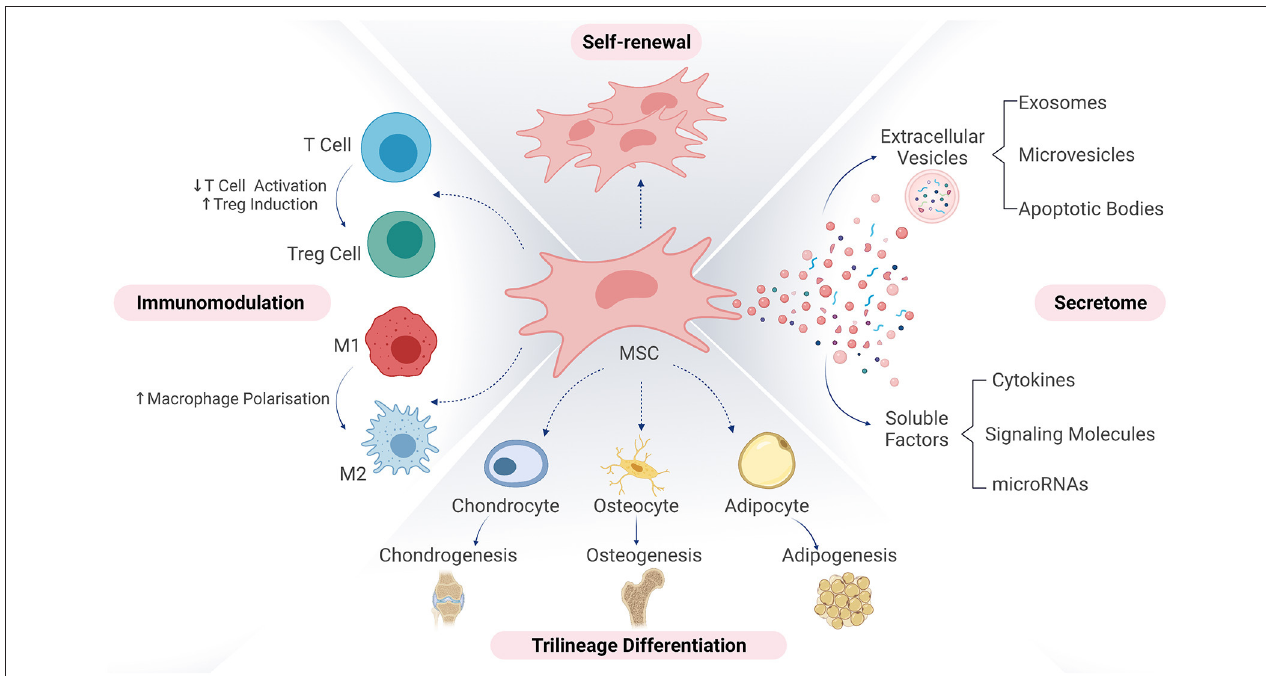
FIGURE 1 | Therapeutic mechanisms of action of mesenchymal stromal cells. MSCs are defined by their ability for self-renewal, proliferation and undergo tri-lineage differentiation into adipogenic, chondrogenic and osteogenic lineages. They contribute to tissue repair via multiple proposed mechanisms of actions. These include a direct contribution to tissue repair via engraftment and cell differentiation but also immunomodulation of host immune system by counteracting the pro-inflammatory cascades and establishing an anti-inflammatory micro-environment for tissue healing and secretion of extracellular vesicles and soluble factors responsible for intracellular communication with target cells. Treg, regulatory T cell; M1, macrophage type 1; M2, macrophage type 2. Figure created with BioRender.com.